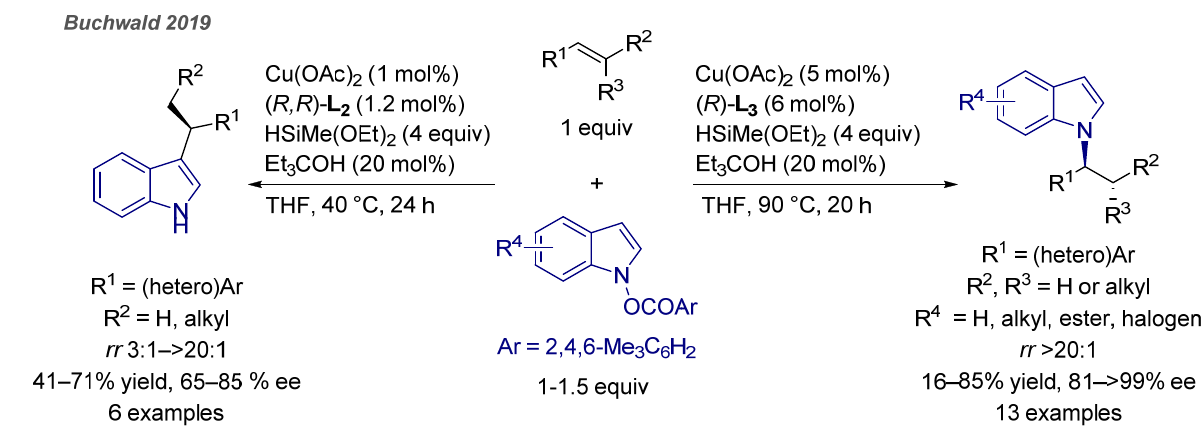
Figure 28. Ligand-controlled regiodivergent synthesis of N - and C3 -alkylated enantioriched indoles by CuH-catalyzed hydroamination. rr = regioselectivity defined as ratio of N - and C3 -isomer. ee = enantiomeric excess.